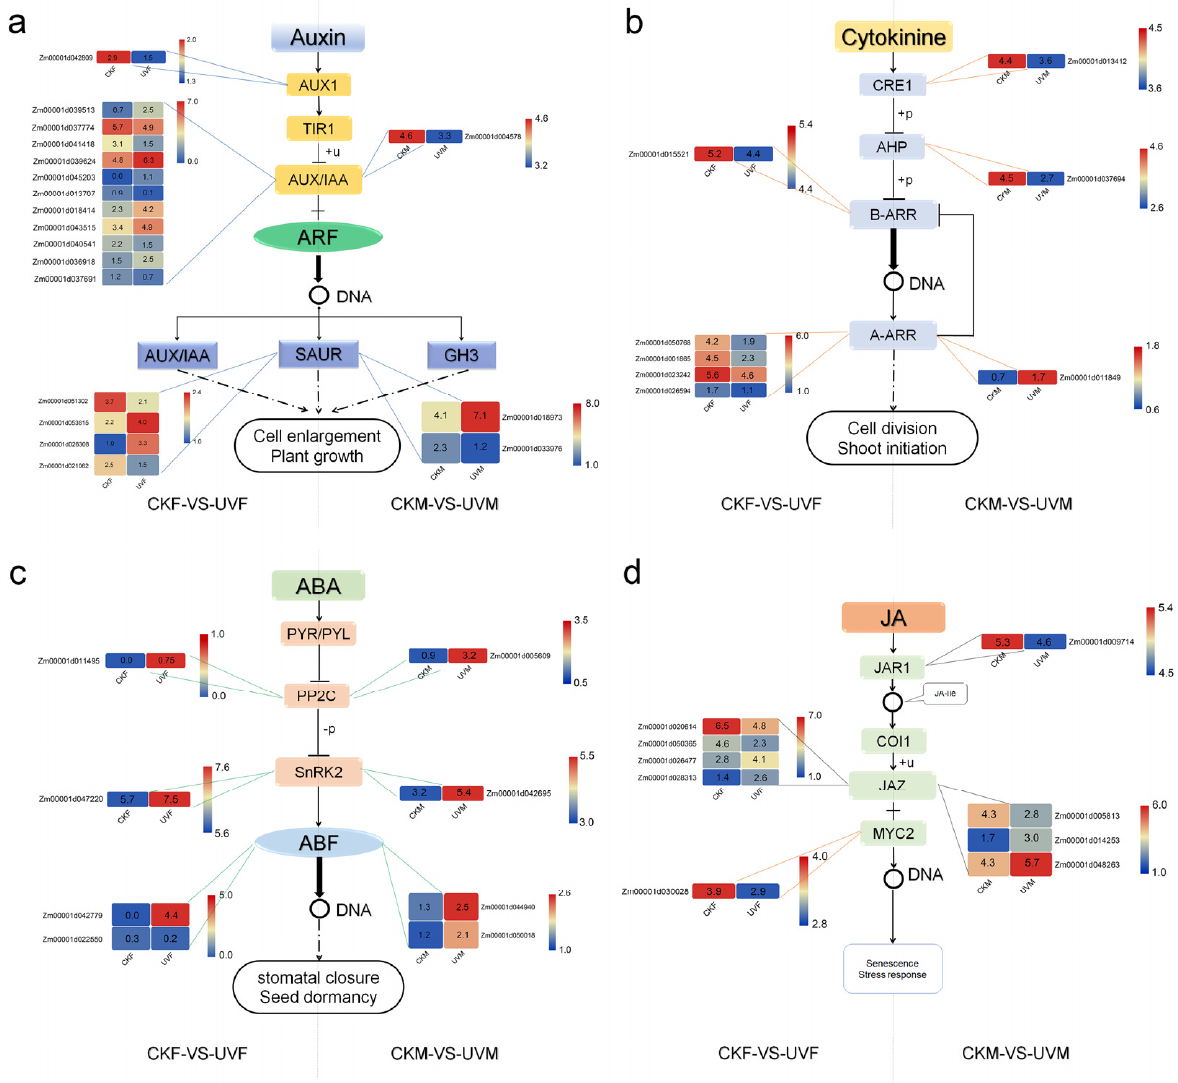
Figure 7. Hormone signal transduction pathways of genotype-specific DEGs in the CKM vs. UVM or CKF vs. UVF comparisons. ( a ) Auxin signal transduction pathway. ( b ) Cytokinin signaling pathway. ( c ) ABA signaling pathway. ( d ) JA signaling pathway. The colored bars indicate the numbers of DEGs for CM37 and cmh15 in the control and salt-treated groups (Log 2 (FPKM +